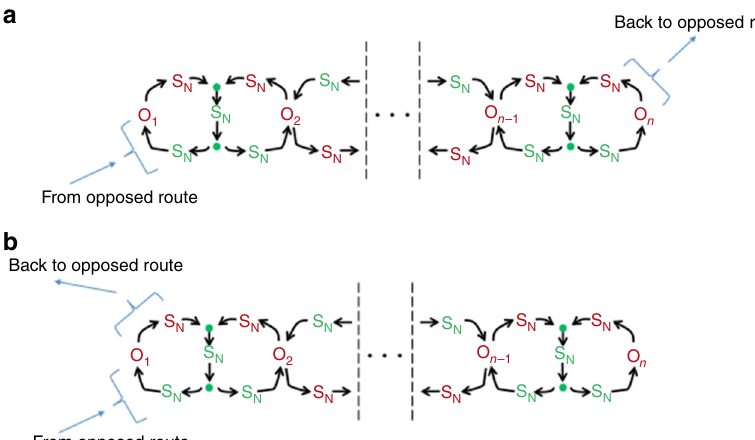
Fig. 4 The general structure of opposing sets. A general representation of the topology of an opposing set — an arrangement of interlinked circuits that are disjoint from the route they oppose, but embedded in some circuit that is contiguous with the route. We refer to the set of all nodes comprising these interlinked disjoint circuits as the master set associated to the opposing set (see Theorem 3). The requirement for each opposer node to have a single independent regulator requires there to be one, and only one, opposer node in each interlinked circuit. This also requires the opposer node from one circuit to be regulated directly or indirectly by a node in the opposed route; all other opposer nodes in the opposing set will have a single independent regulator that is internal to the collection of disjoint circuits. The opposer nodes O i , and their dependents (all marked in red) do not exhibit RPA. The single independent regulator of each opposer node, and its dependents (all marked in green) do exhibit the RPA property. Thus, any outgoing regulation from a node marked in red will be a live regulation; any outgoing regulation from a node marked in green will be a blind regulation. This has important implications for the interconnections of the module with other parts of the RPA-capable network. The symbol S N indicates that any motif or sub-network may be fully embedded at the indicated position. a For illustrative purposes, an example is shown where the opposer node from one of the disjoint circuits has a single independent regulator that comes from the opposed route; the opposer node, or one of its dependents, from some other disjoint circuit in the collection then regulates the opposed route, thus forming a contiguous circuit into which the opposing set is embedded, as required. b For illustrative purposes, an example is shown where a single opposer node in the opposing set is regulated by a route note, and also regulates a route node, thus forming the requisite contiguous circuit for the embedding of the opposing